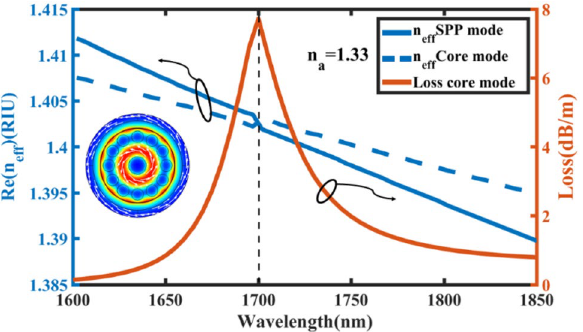
Figure 5. The real part of the effective index for the cylindrical vector mode of the core (dashed blue line), SPP mode (solid blue line) and the loss spectrum of core mode (solid red line) for the C-PCF-based SPR sensor with